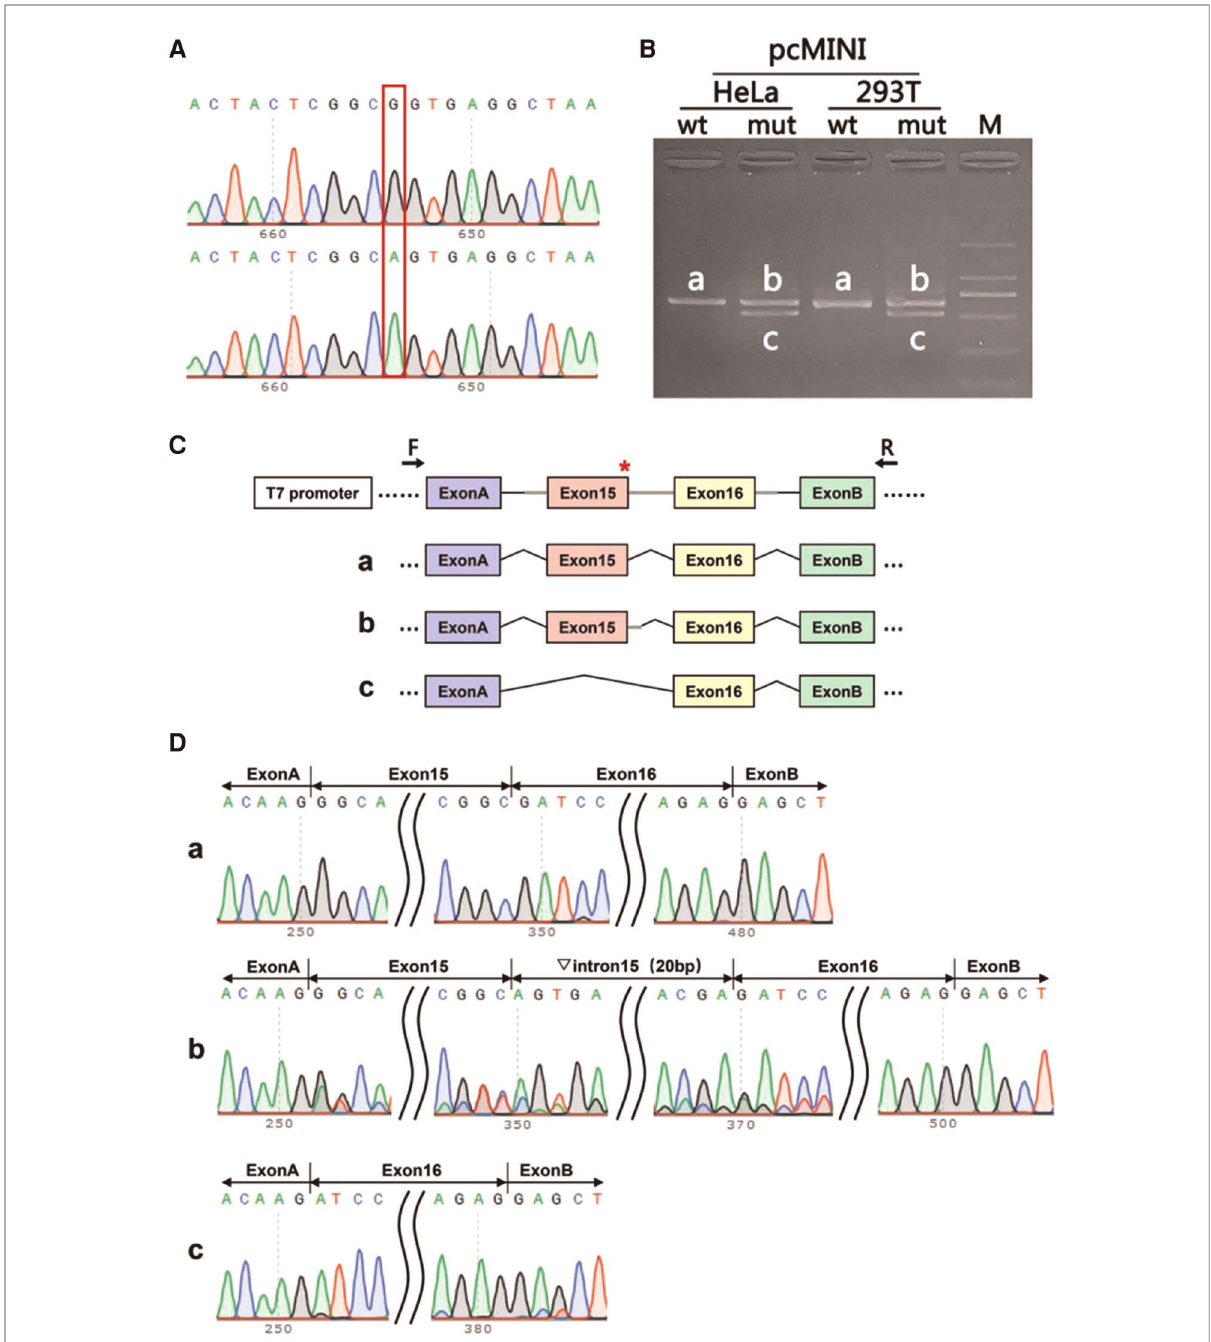
FIGURE 4 The splicing assay had been performed on mRNA obtained from the parent harboring the synonymous variant c.1860G>A. ( A ): The sequencing diagram of minigene assay, wild-type(wt) on the top and mutation (mut) on the bottom; ( B ): The gel diagram of RT-PCR transcriptional analysis. The differential bands in 293T and Hela cells were labeled a,b,c; ( C ): Minigene construction and splicing diagram; ( D ): The corresponding sequencing map to the splicing bands. Red* indicates the location of the